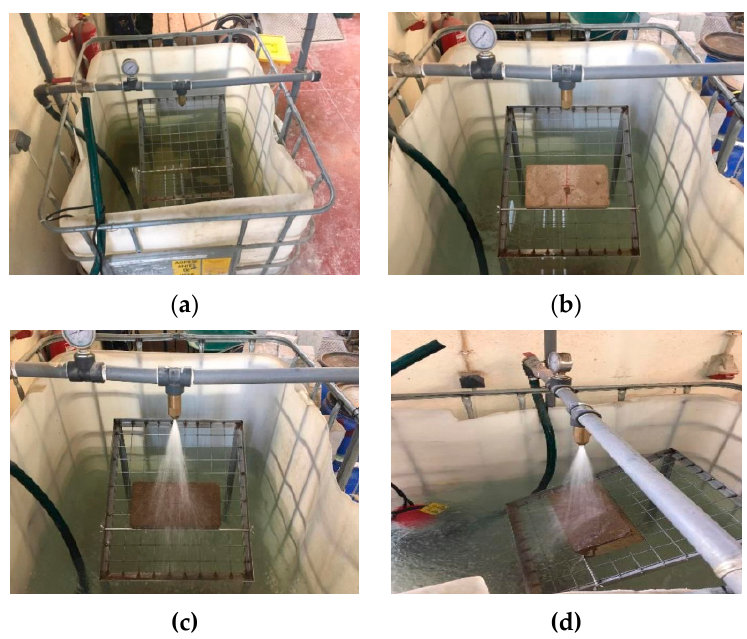
Figure 6. Accelerated erosion test: ( a ) setup; ( b ) sample preparation; ( c ) and ( d ) sample test.